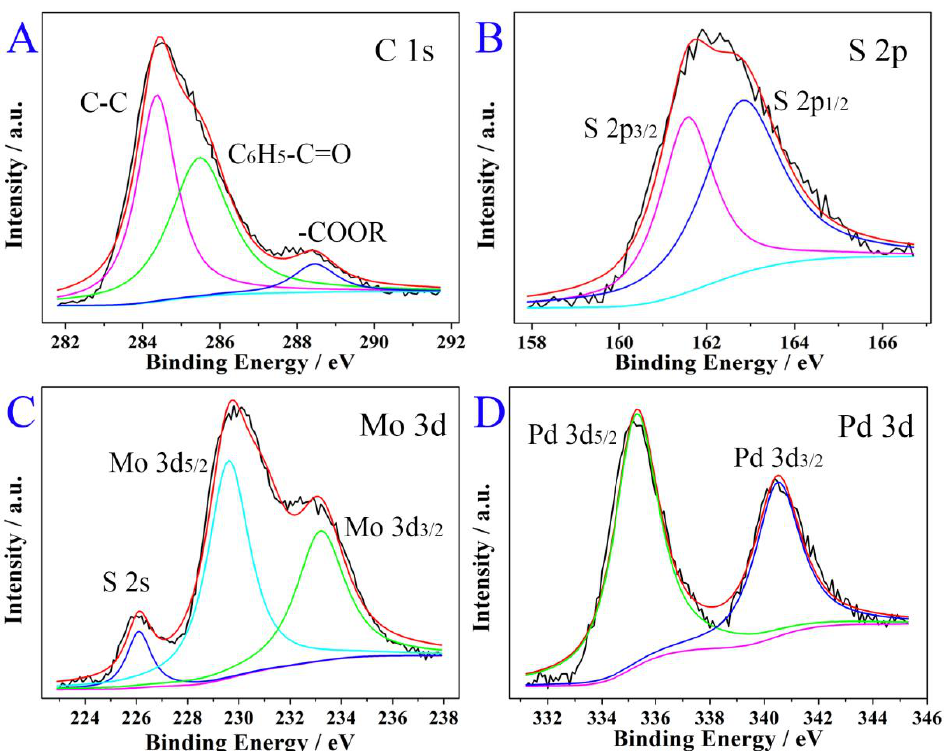
Figure 3. High-resolution XPS spectra for Cs@MoS 2 -Pd NPs: C 1s ( A ), S 2p ( B ), Mo 3d ( C ), Pd 3d ( D ).